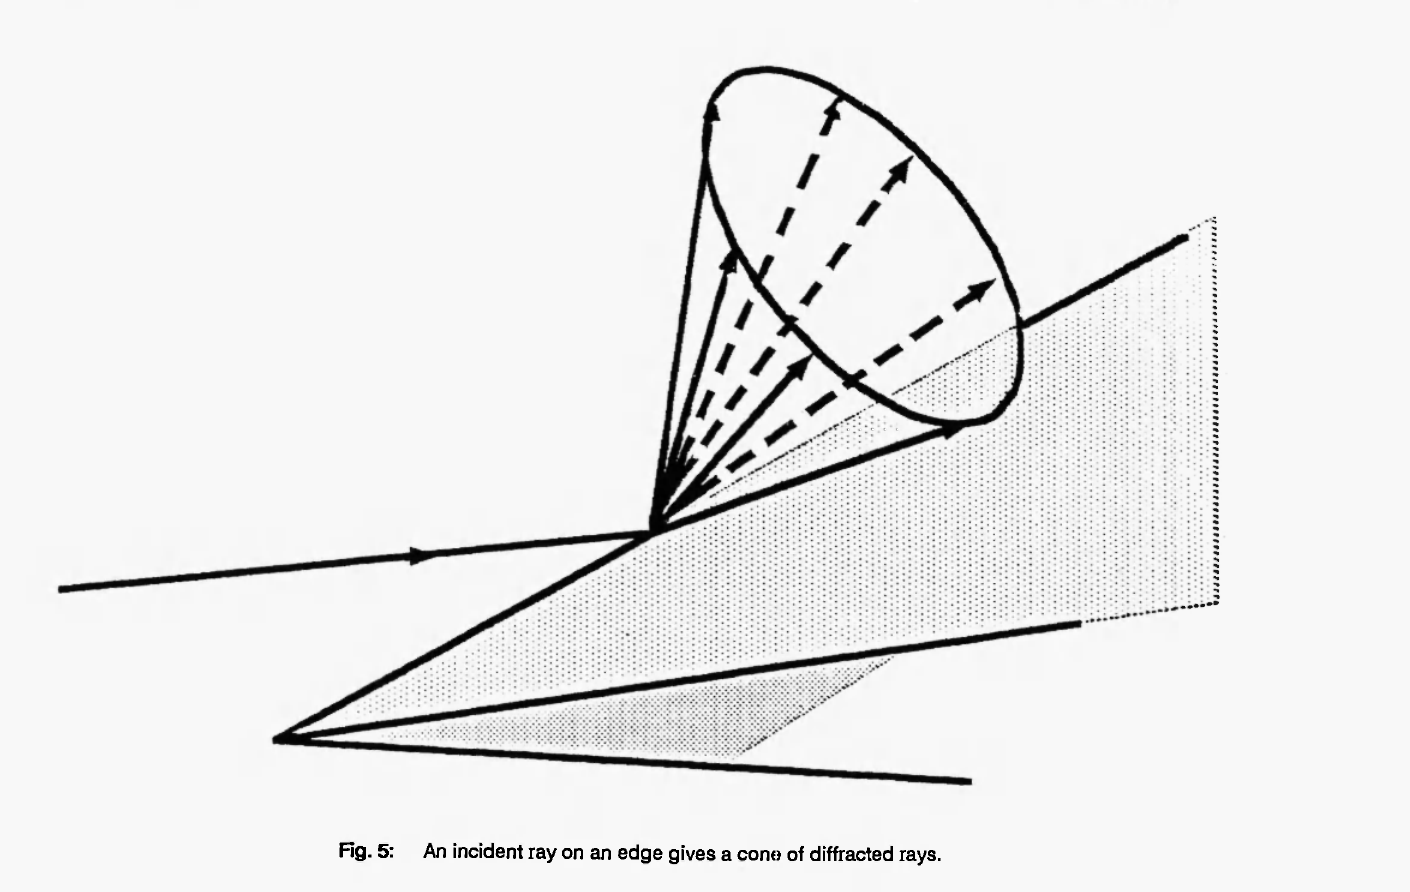
Fig. 5: An incident ray on an edge gives a cono of diffracted